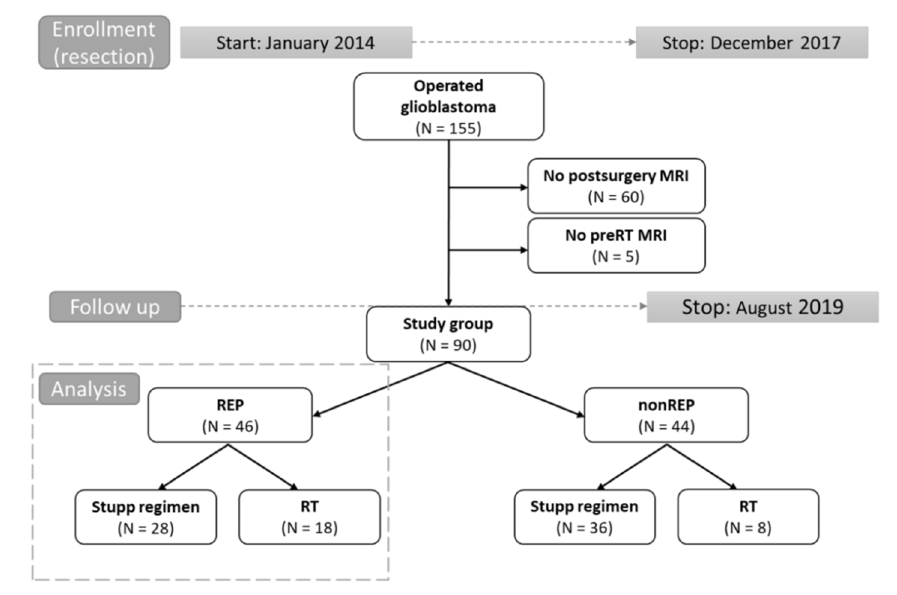
Figure 1. Design of study (flow chart). Grey dot line: time to study enrolment and follow up, respectively. Black line arrows: division into parts. Grey dot line box: cohort analyzed in more detailes.